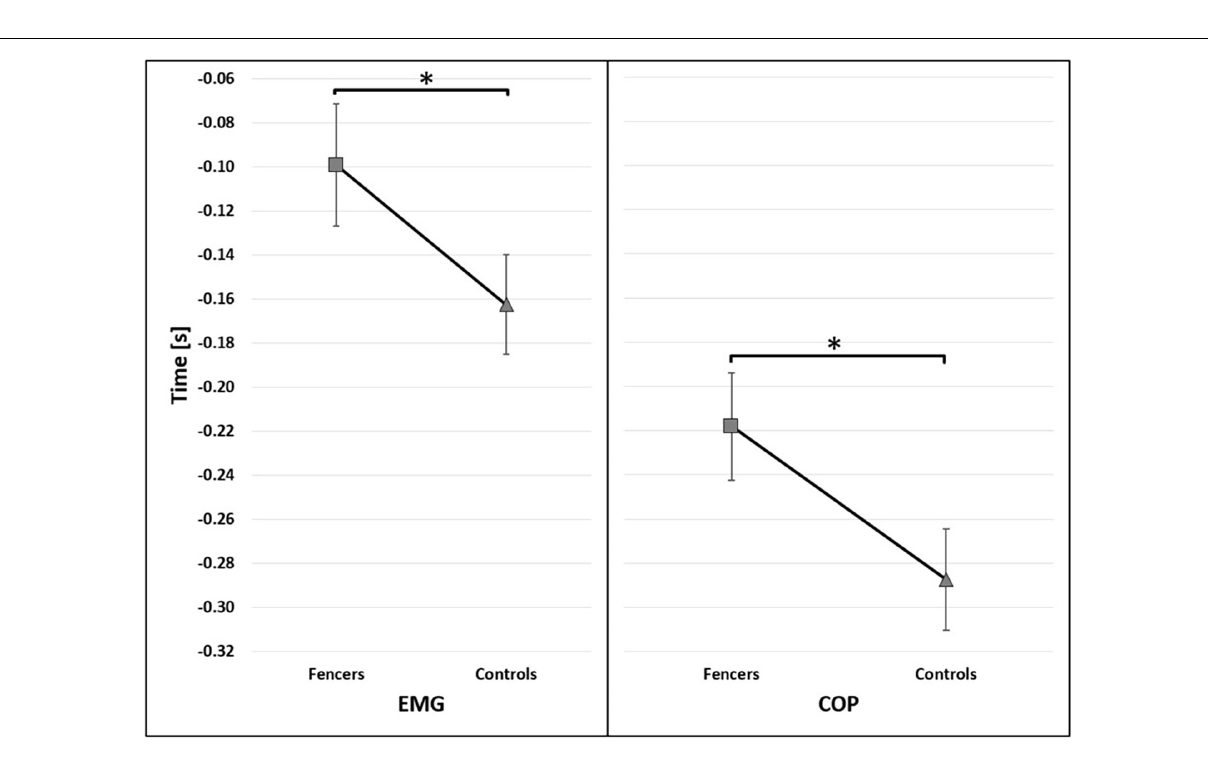
Frontiers in Human Neuroscience |